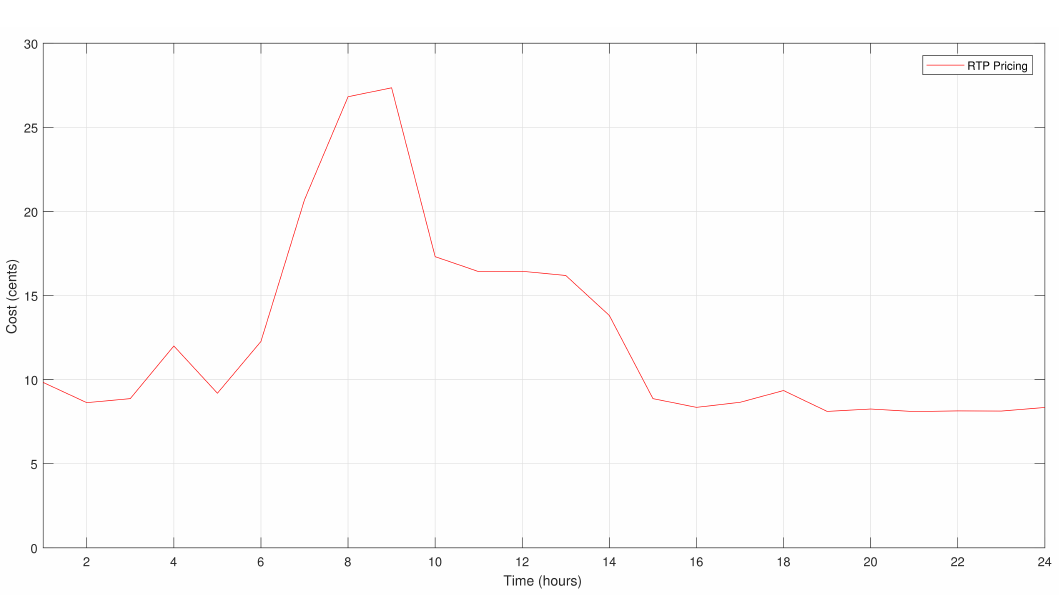
Figure 3. RTP pricing